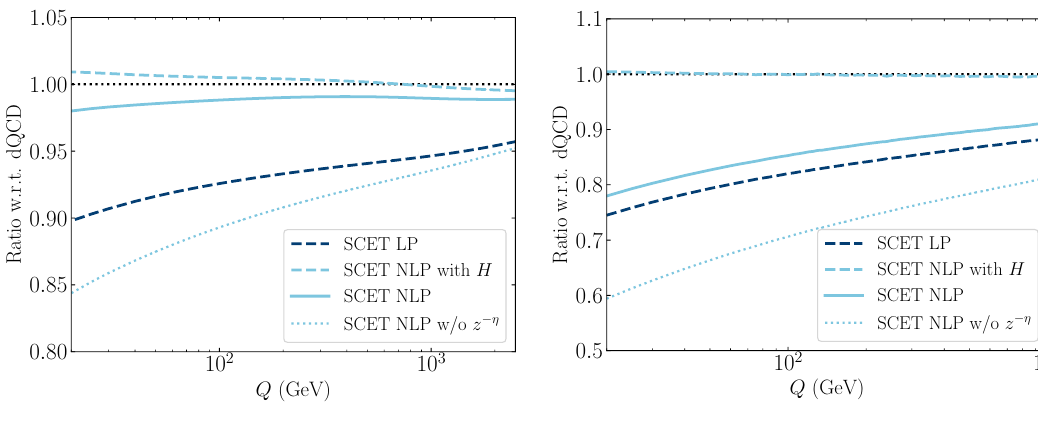
Figure 15. Ratio plots for the NNLL results for DY (left) and Higgs (right) with respect to the dQCD distributions. The SCET LP result at NNLL (dark-blue dashed line) is divided by the dQCD result at LP NNLL. The SCET NLP results indicated by the light-blue lines are obtained via eq. (5.65) (dashed), eq. (5.24) (dash-dotted) and eq. (5.24) (dotted), and divided by the dQCD result at LP NNLL + NLP